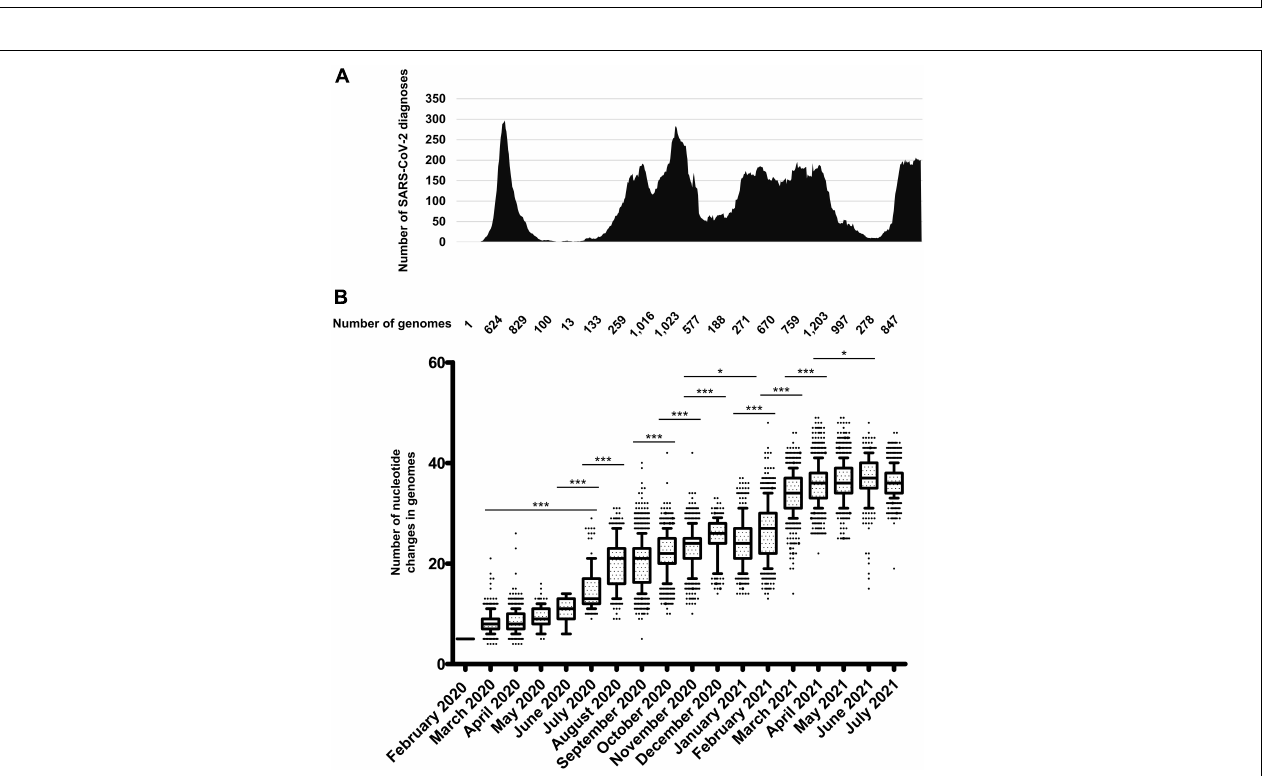
FIGURE 2 | Chronological distribution of SARS-CoV-2 diagnoses by qPCR at IHU Méditerranée Infection institute (A) , and of mean ( ± standard deviation) numbers of mutations in SARS-CoV-2 genomes obtained from patients sampled per month (B) . (A) Chronological distribution of SARS-CoV-2 diagnoses is the mean number of diagnoses by qPCR per sliding windows of 7 days and steps of 1 day. (B) Numbers of mutations in SARS-CoV-2 genomes were calculated in reference to the genome of the Wuhan-Hu-1 isolate (GenBank Accession no. NC_045512.2). Whiskers indicate 10–90 percentiles. * p < 10 − 1 ; *** p < 10 − 3 .